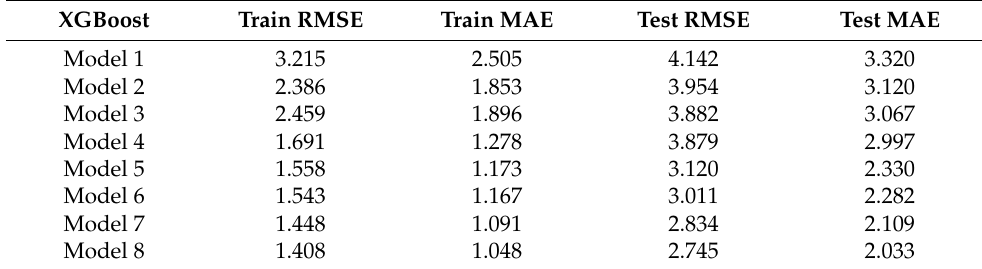
Table 7. Train and test RMSE and MAE for all XGBoost models.